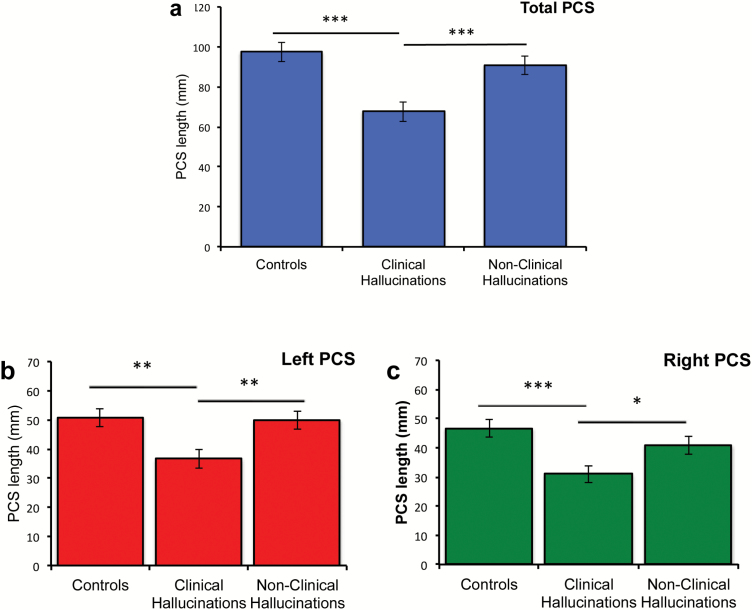
Paracingulate sulcus (PCS) length by group. (a) Total PCS length across both hemispheres, (b) PCS length in the left hemisphere, and (c) PCS length in the right hemisphere. ***P < .001, **P < .01, *P < .05. Error bars represent standard error of the mean. Variation is also seen between the groups for the proportions of absent PCS. Taking an earlier definition of an absent PCS to be one of length <20 mm,11,12 11% of the brain hemispheres measured in control subjects had no PCS compared with 20% for nonclinical individuals with hallucinations, and 33% for individuals in the clinical group.